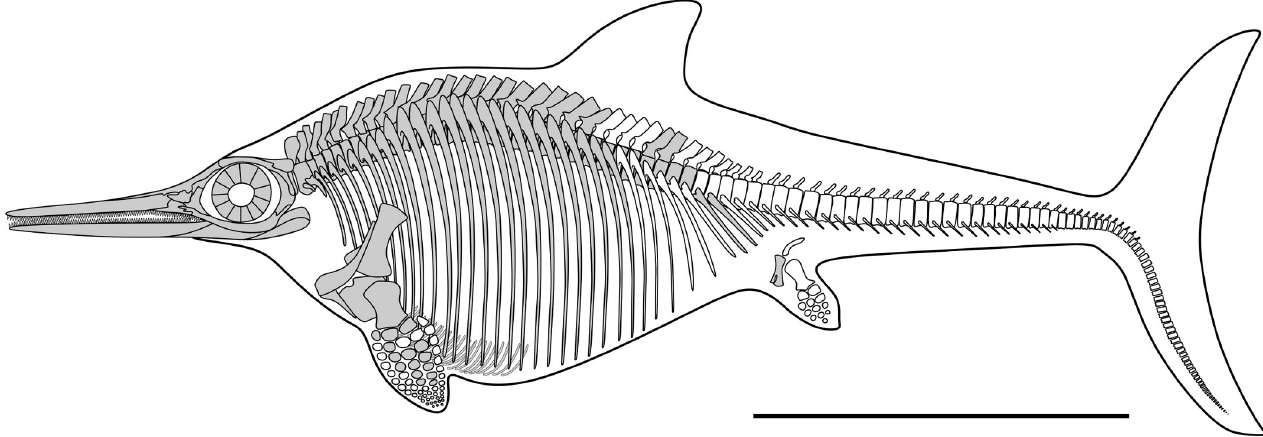
Fig 6. Skeletal reconstruction of Thalassodraco etchesi MJML K 1885. Grey areas indicating bones present. Scale represents 1 m.